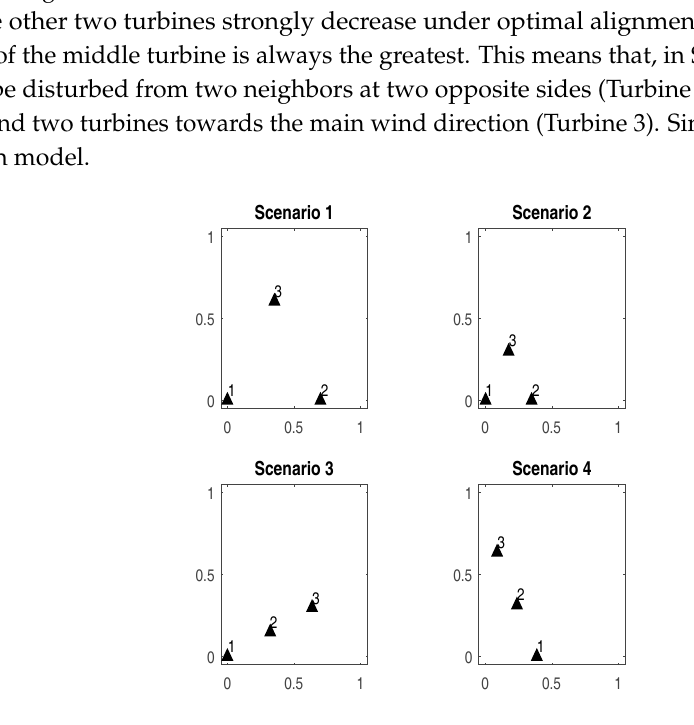
Figure 8. Layout of the hypothetical wind farm designs.